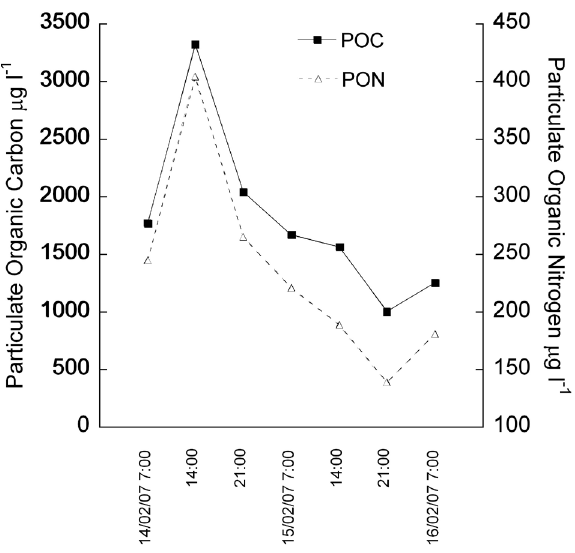
Fig . 2. – Particulate organic carbon (POC) and particulate organic nitrogen (PON) (µg L -1 ) during the 48-hour cycle at Chipana